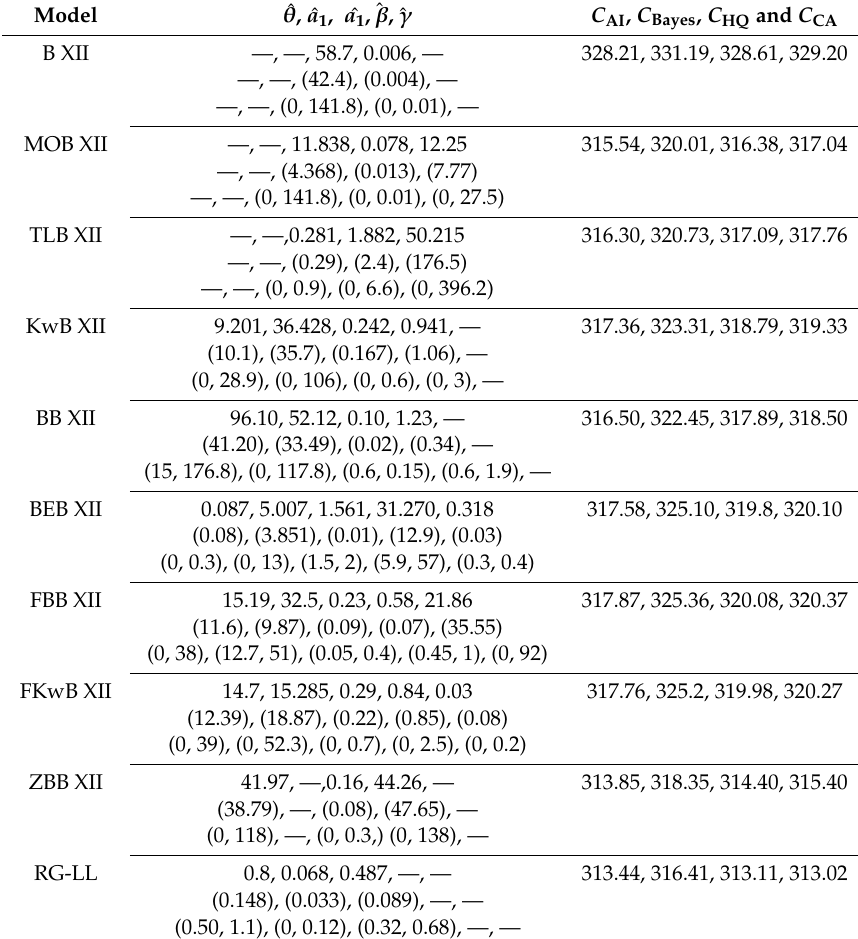
Table A5. MLEs, SEs, and CIs with C AI , C Bayes , C HQ and C CA for the leukemia